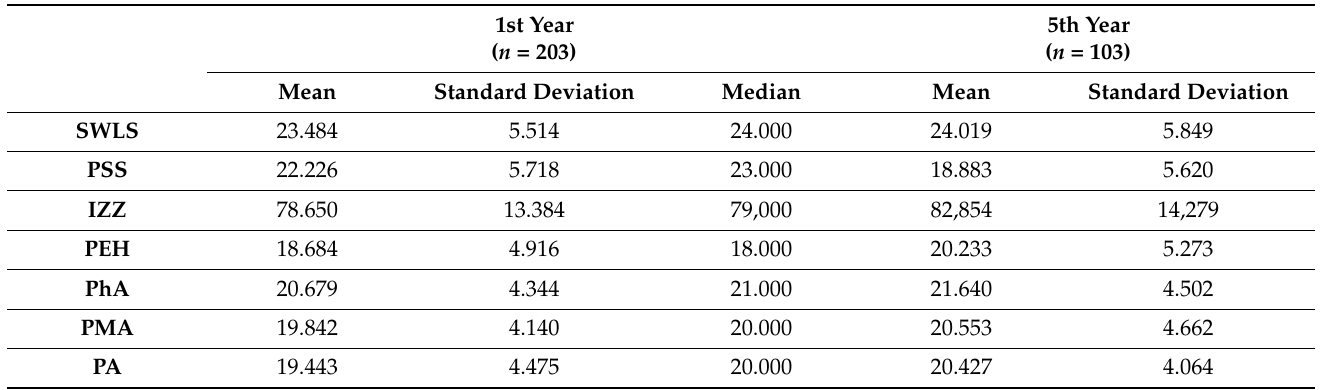
Table 3. Differences between 1st- and 5th-year